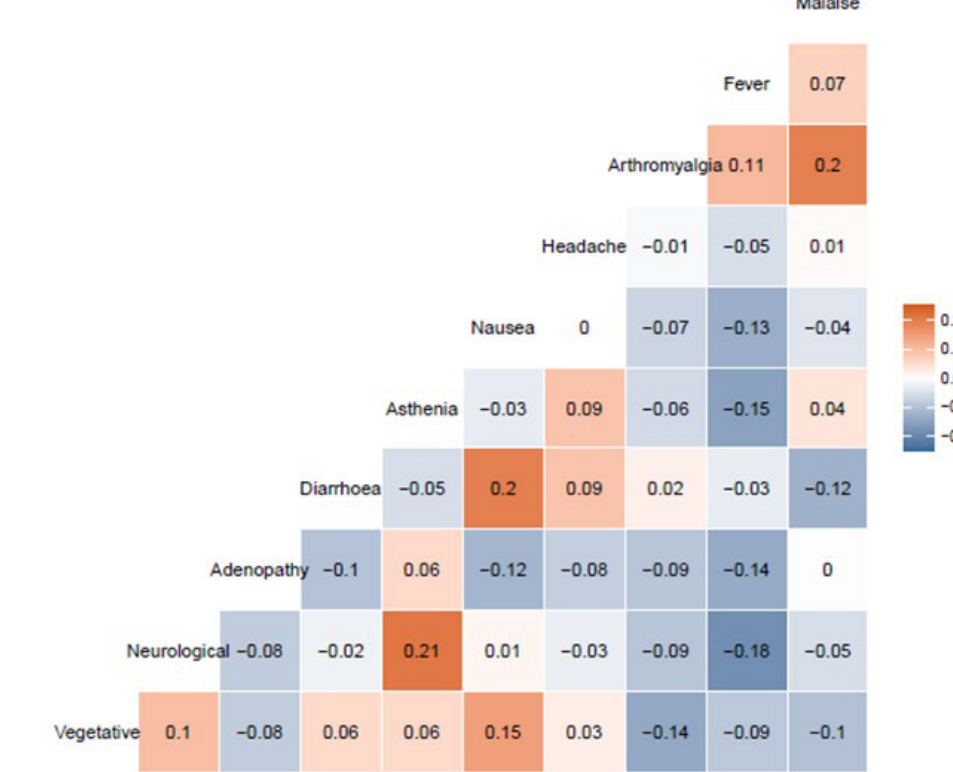
Figure 2. Dendrogram for cluster analysis of adverse reactions to BNT162b2 vaccine. The strongest relationships between the symptoms are marked by lower links on the y-axis. NVS, neurovegetative symptoms; NS, neurological symptoms; CS, catarrhal symptoms.